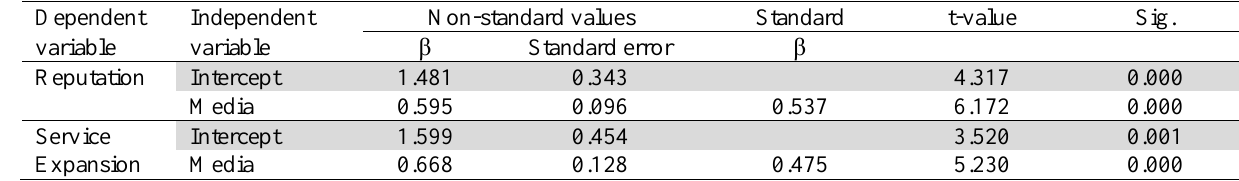
The results of regression analysis for testing the effect of media content on firm’s